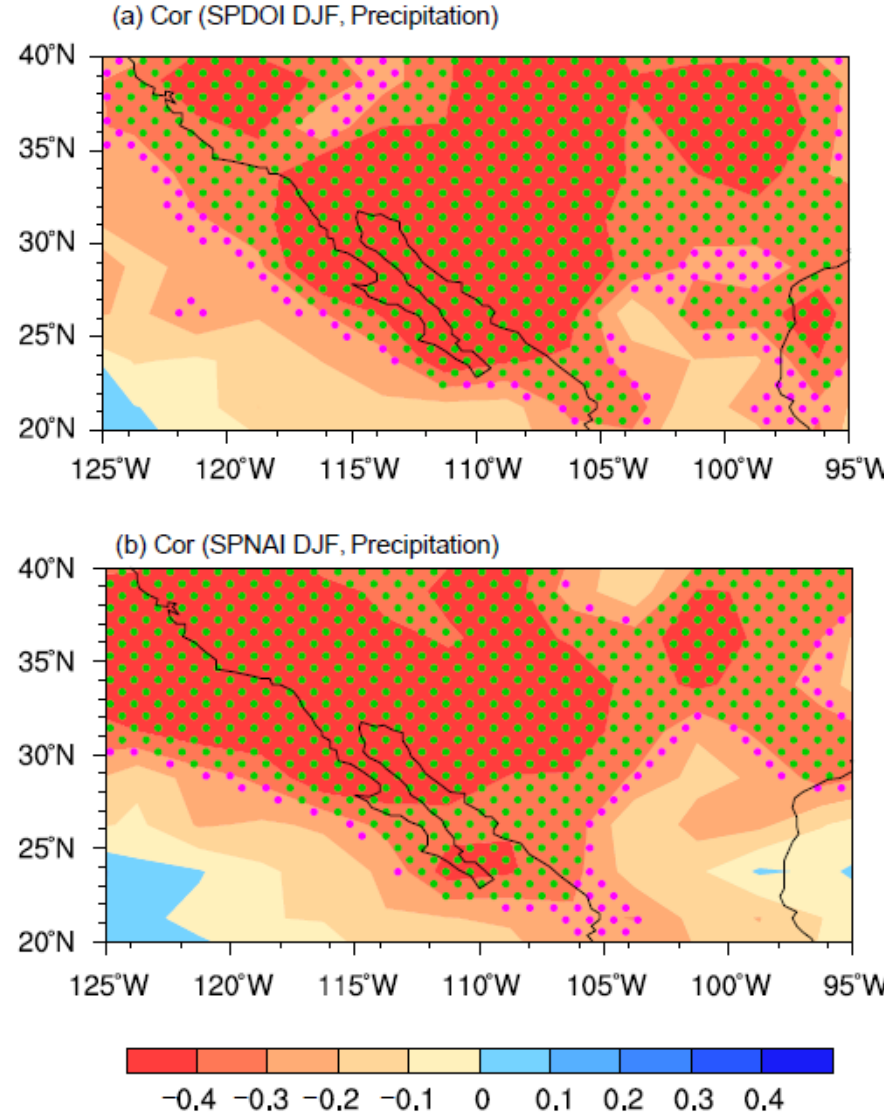
Figure 8. Partial correlation maps between the winter ( a ) south Pacific Ocean dipole (SPOD) index (SPODI) and ( b ) Southern Pacific–North America teleconnection (SPNA) index (SPNAI) and winter precipitation without the ENSO signal. The magenta and green stippled areas indicate statistical significance at the 90% and 95% confidence levels, respectively.